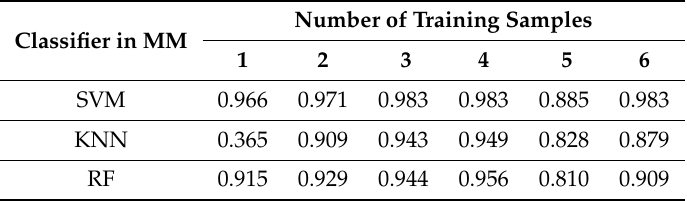
Table 2. Verification accuracy obtained using different classifiers on the 2D contact-free HKPU database.